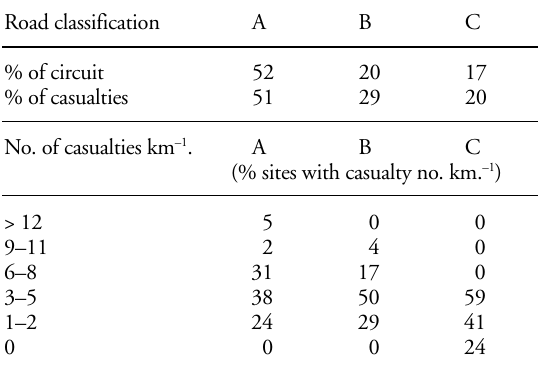
No. of casualties km –1 .